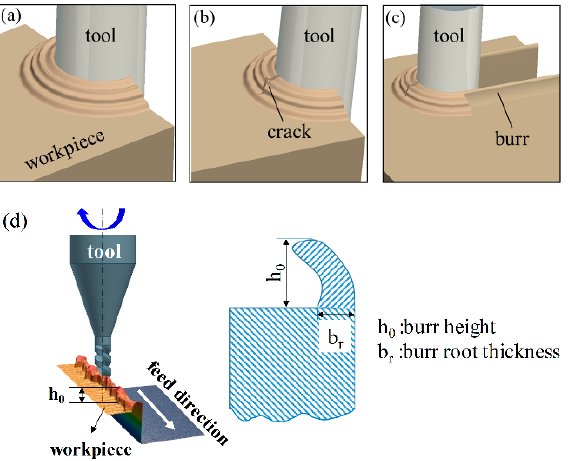
Figure 7. Modeling of burr formation during micro end milling: ( a – c ) The milling process of polymer, ( d ) the schematic of burr height and burr root thickness.